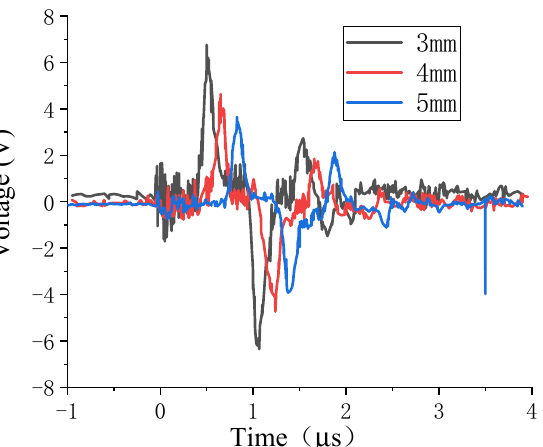
Figure 17. Measured and calculated results of thermal shock waves for aluminum and carbon phenolic materials.